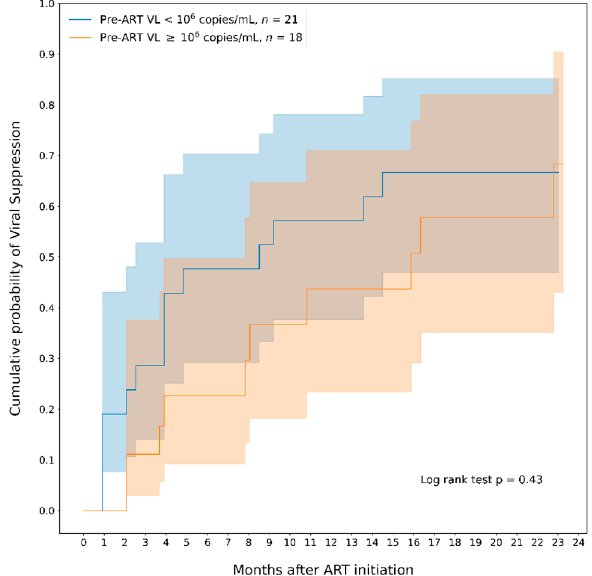
Figure 2. Cumulative probability of viral suppression (VL ≤ 400 copies/mL) among all infants who started ART according to pre-ART viral load. Note. The areas in blue and in orange represent the 95% CI.